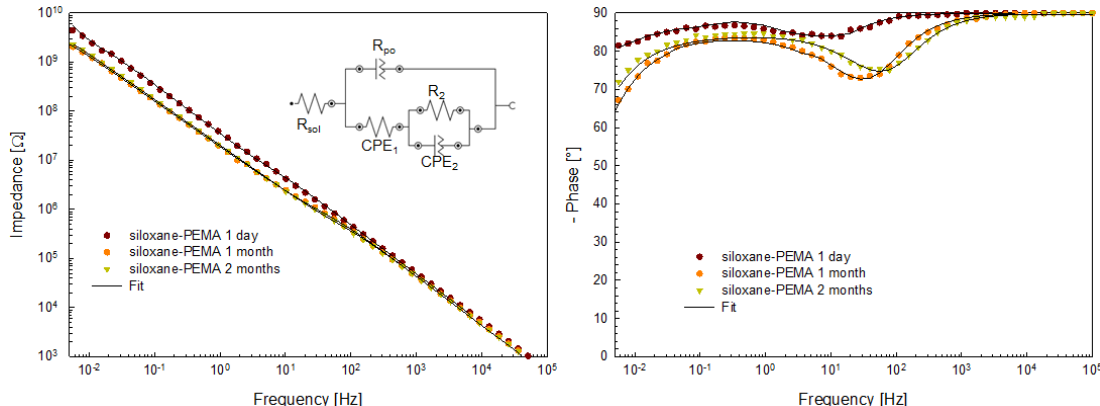
Figure 10. Bode plot of impedance magnitude and phase angle of AA7075-T6 coated with siloxane-PEMA measured after immersion in 0.1 M NaCl for up to 2 months. Symbols correspond to the experimental data and lines to the fitted curves. Electrical equivalent circuit used to fit the experimental data is given in inset; fitted parameters are presented in Table 5. Table 5. Fitting parameters for the impedance measurements plotted in Figures 9 and 10 using denoted electrical equivalent circuit. Siloxane-PMMA Sample